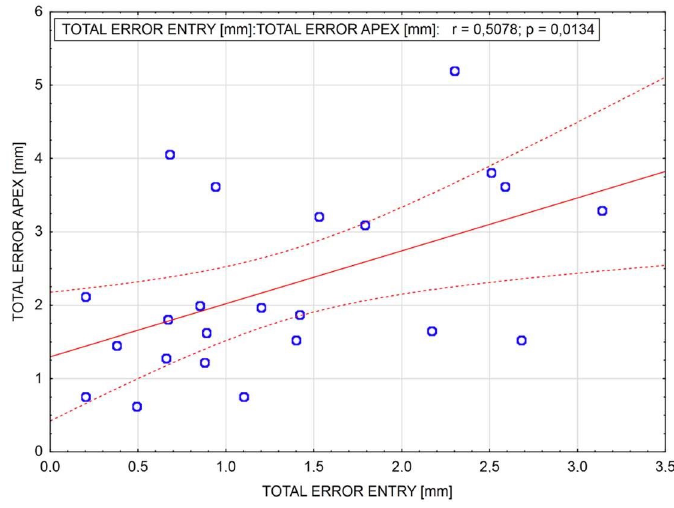
Figure 7. The dependence of the total error (TE) at APEX from TE at ENTRY. Figure 9. The dependence of the total error (TE) at APEX from TE at